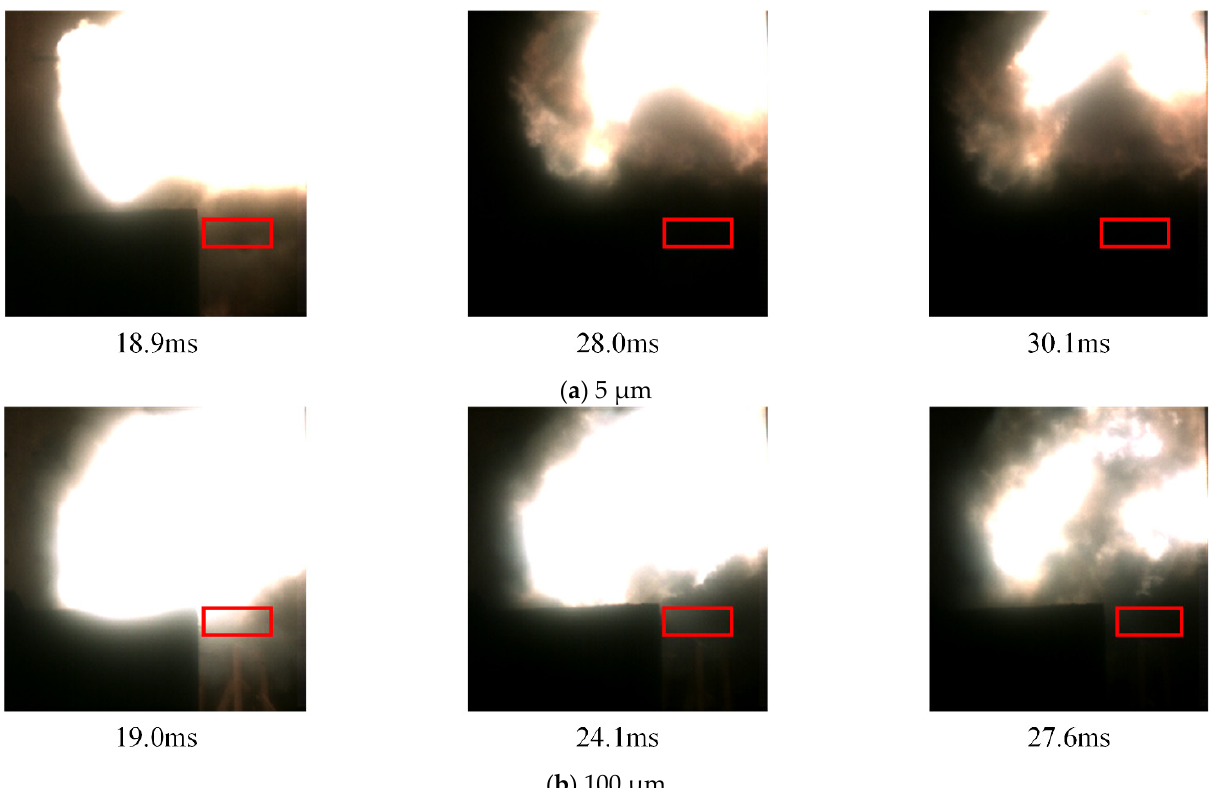
Figure 6. The position of firelight contraction. ( ▭ :The target location).